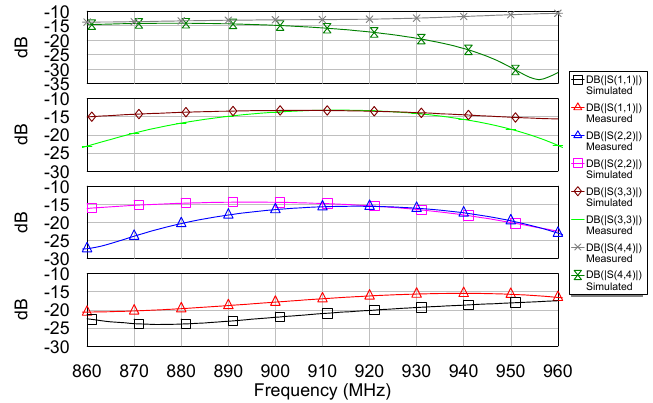
Figure 13. Experimental and simulated input